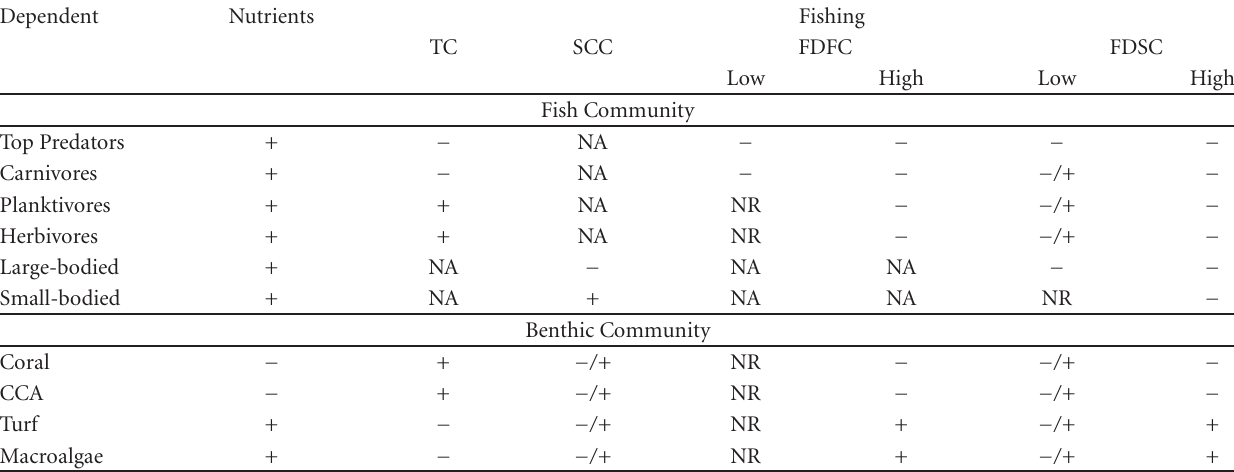
Figure 2: Chlorophyll- a (a proxy for nutrients) and fishing conditions. Island-wake upwelling in the northwest results in higher chlorophyll- a concentrations (September 16, 2002 to August 16, 2007 monthly average values). Fishing trips (represented as circles) cluster near the villages (represented as squares). Table 1: Hypotheses for independent e ff ects of nutrients and fishing ∗